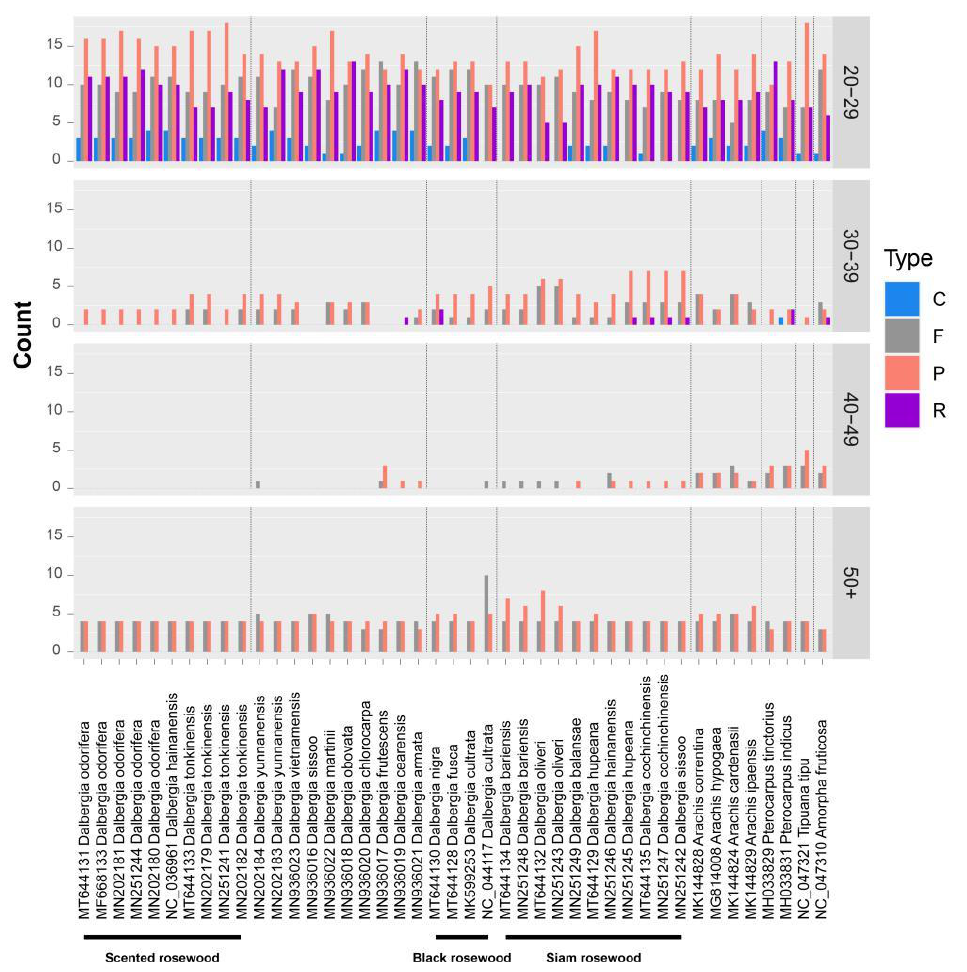
Figure 3. Variation in repeat abundance and type in 43 chloroplast genomes.